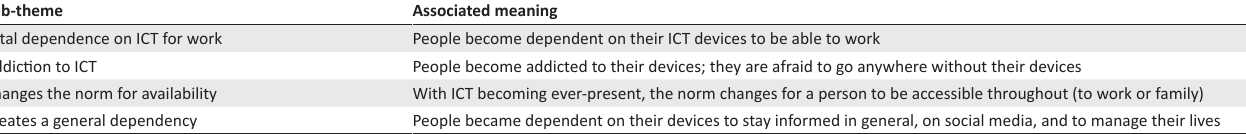
TABLE 3: Theme 3: The dependency on ICT usage. Sub-theme